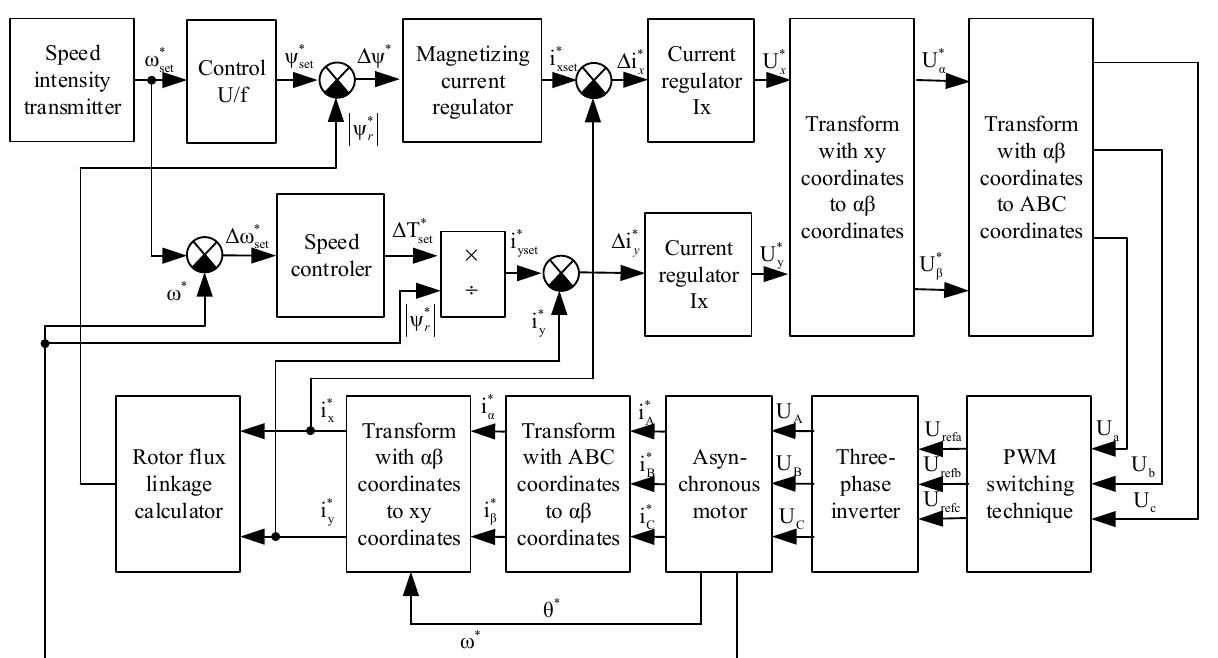
Figure 1. Structural scheme of the vector control system (* values presented in relative units of measurement).